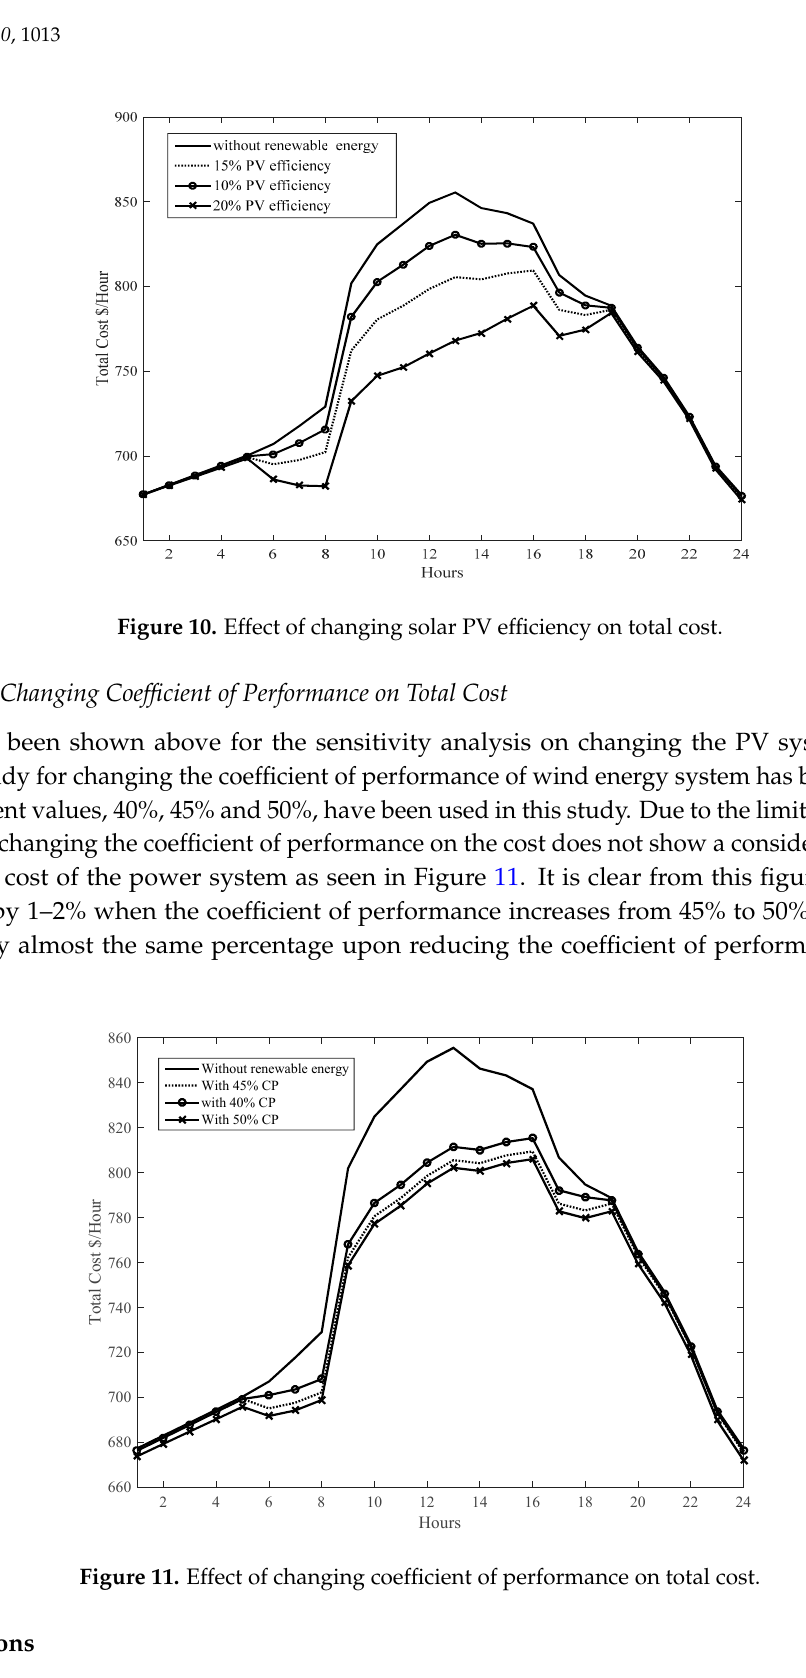
Figure 9. Effect of change in renewable energy and load in transmission losses. 4.3. Effect of Changing Solar PV Efficiency on Total Cost The efficiency of PV system has a great influence on the total cost of the PV system. The efficiency